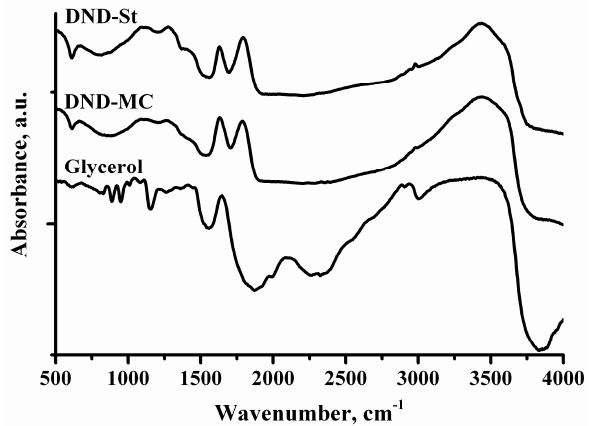
Figure 3. FTIR spectra of DND-St and DND-MC samples, and glycerol. Table 1. Percentage of DND particles with sizes less than 4 nm. Method\Sample